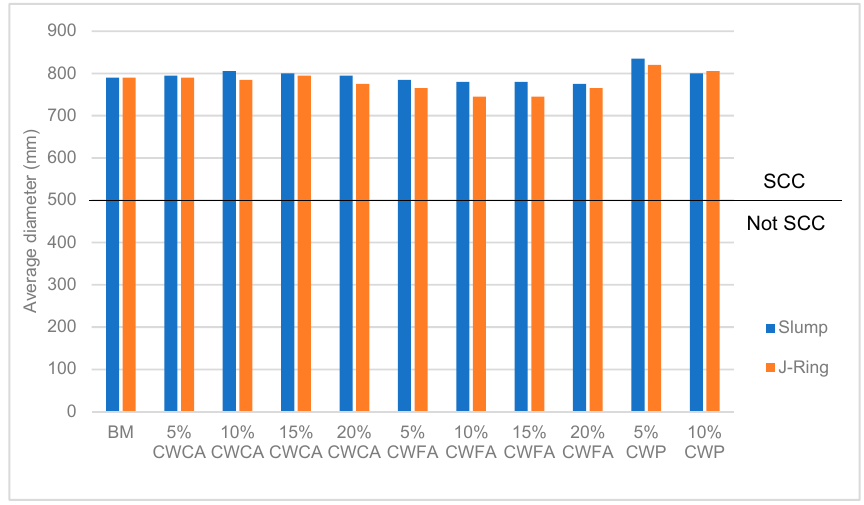
Figure 3. Results of the J-Ring flow and slump flow for SCC samples containing varying doses of ceramic waste coarse aggregate (CWCA), ceramic waste fine aggregate (CWFA), and ceramic waste powder (CWP).